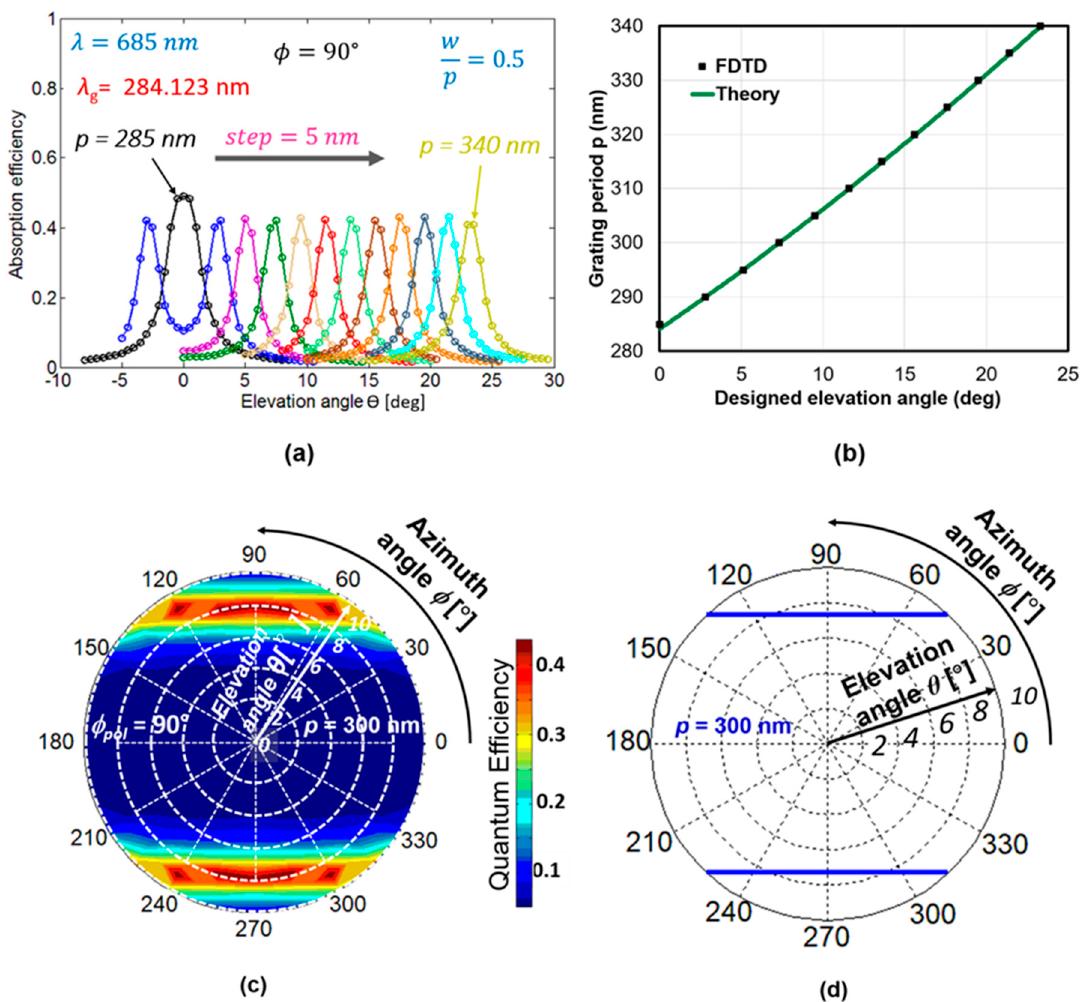
Figure 5. ( a ) Absorption efficiency as a function of the elevation angle in SOI PD with 1D L/S SP antenna (FDTD calculation) with various grating periods p ; ( b ) Comparison of appropriate grating periods for designed peak elevation angle estimated by FDTD method and phase matching condition. ( c ) Calculated spatial pattern of absorption efficiency at φ pol = 90° and ( d ) theoretical spatial pattern of peak incident angles based on the phase matching condition. Grating period is fixed at p = 300 nm.